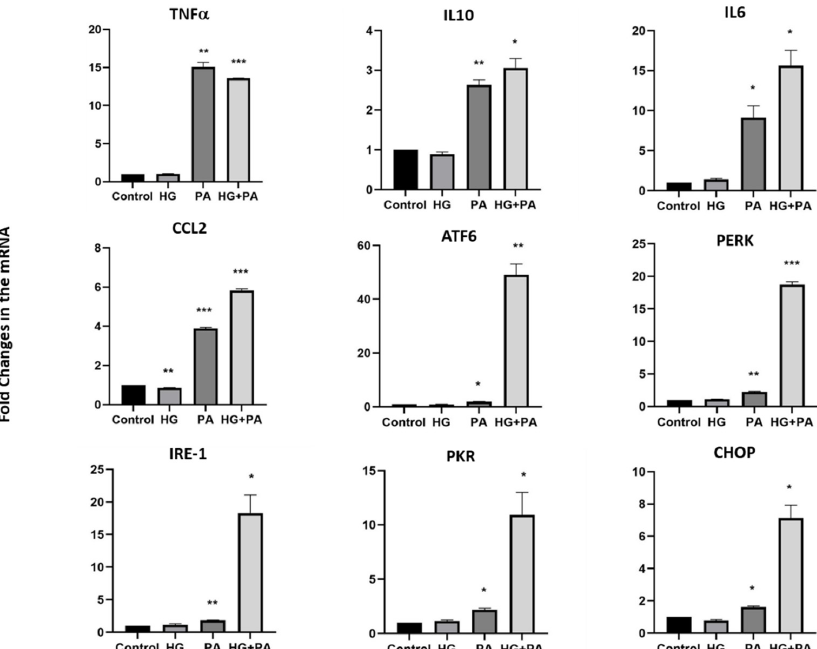
Figure 5. Gene expression levels of inflammatory and ER stress markers in THP1 cells treated for twenty-four hours. Gene expression levels of inflammatory markers (TNF α , IL10, IL6, CCL2) and ER stress markers (ATF6, PERK, IRE1, PKR and CHOP) were measured by quantitative real-time PCR in THP1 cells treated with high glucose (25 mM), palmitate (200 µM) and their combination for 24 h ( n = 3 for each condition). Data are normalized to internal GAPDH and presented as fold-change compared with Control data. One-way ANOVA with repeated measurements followed by Sidak´s post hoc test were used to determine the significance of differences in means between the groups (* p < 0.05, ** p < 0.01, *** p < 0.001).